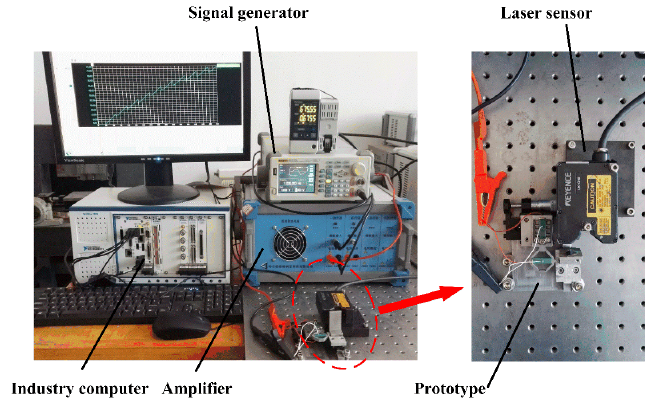
Figure 7. Experimental system and the prototype of the designed actuator.